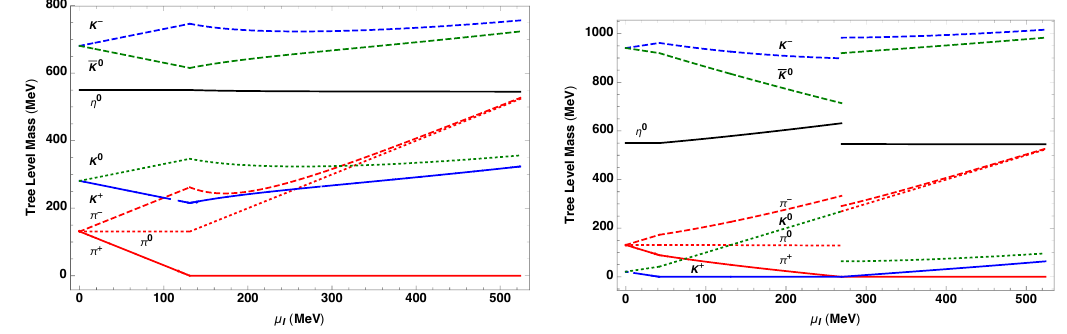
Figure 3 . Medium-dependent masses as a function of (cid:22) I for (cid:22) S = 200 MeV (left panel) and (cid:22) S = 460 MeV (right panel). See main text for